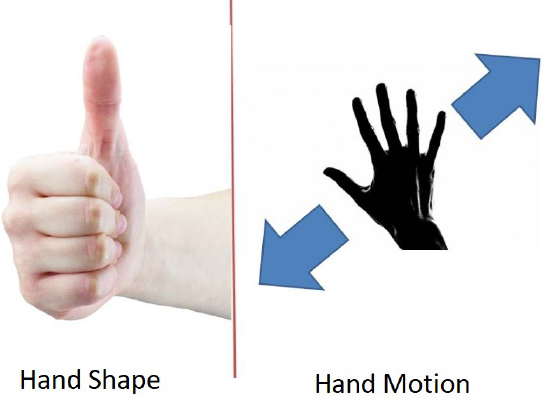
Figure 3. Hand shape and hand motion factors for sign languages.